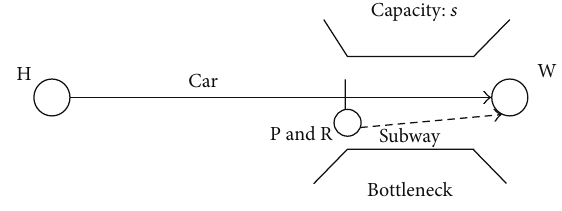
Figure 1: The simple commuting